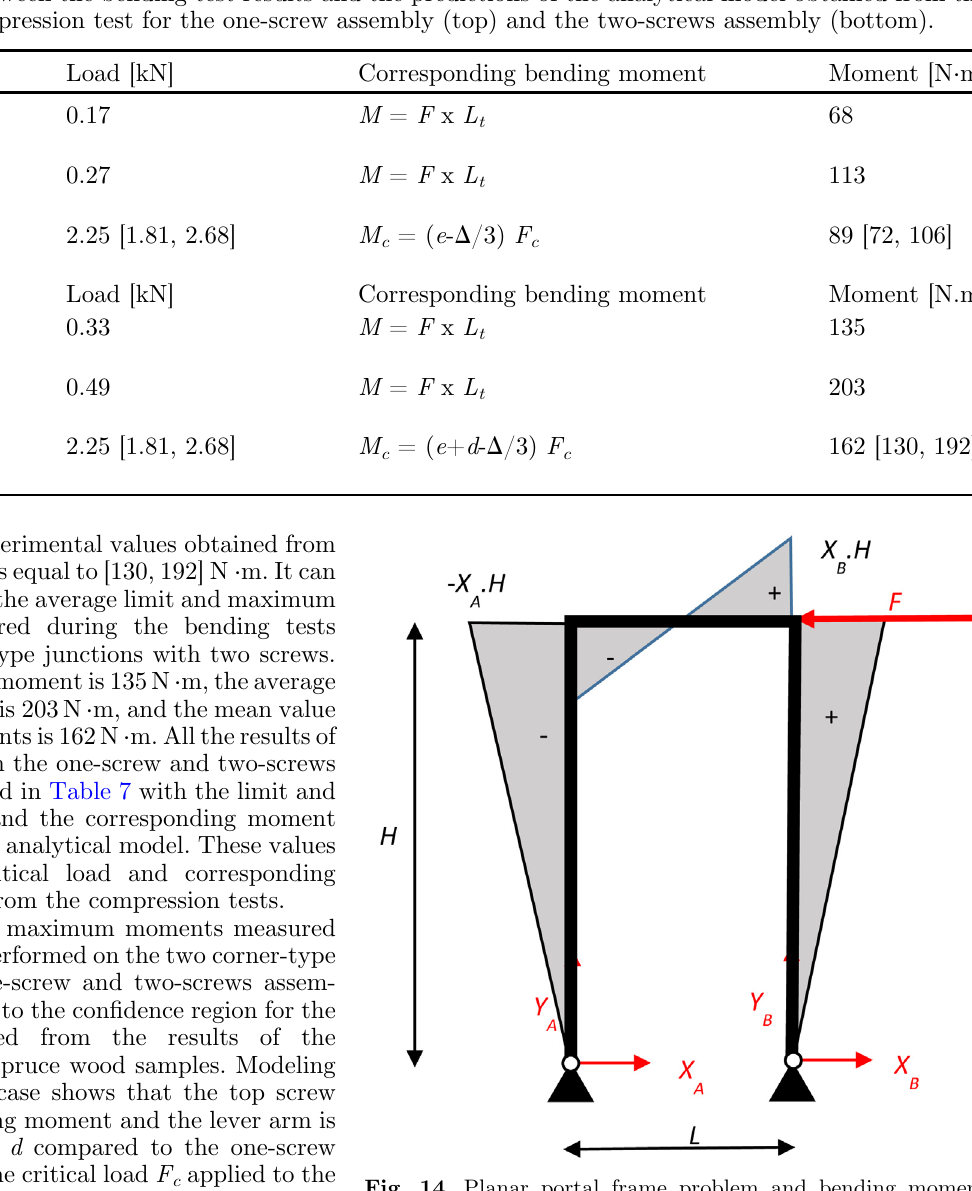
Fig. 14. Planar portal frame problem and bending moment